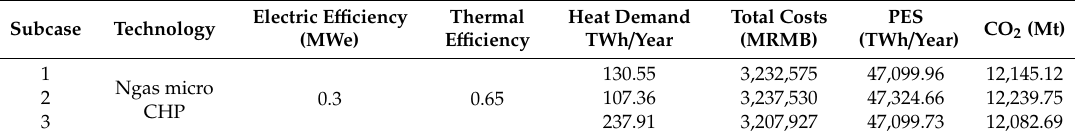
Table 6. Case 2 (Ngas Micro CHP) Components Specifications and Summary